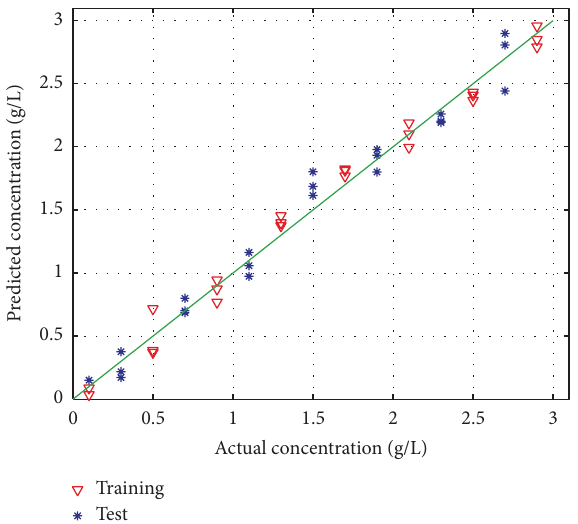
Figure 6: Scatter plots of predicted versus actual melamine concen- tration in milk samples for the UVE-PLS